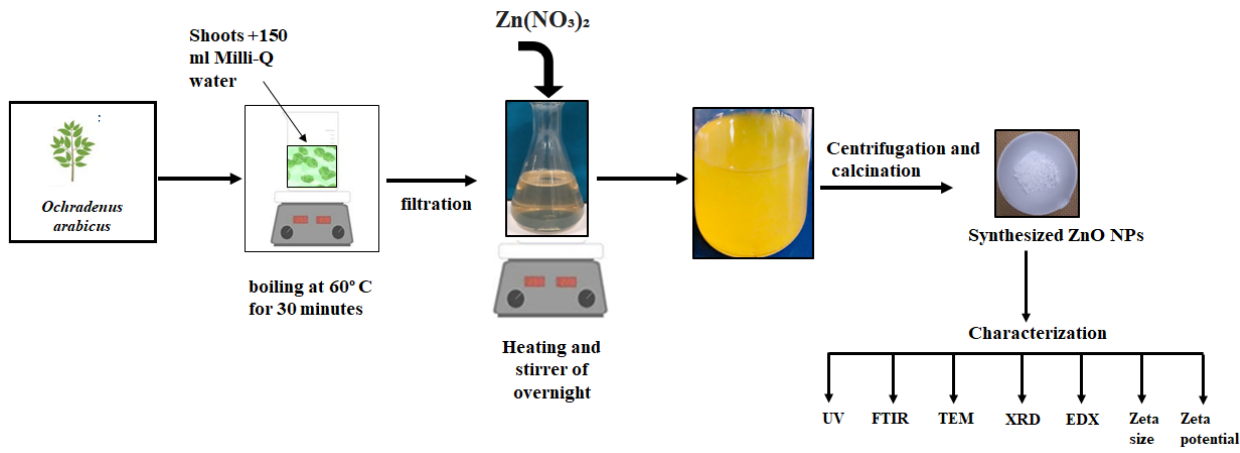
Figure 1. Steps of biogenic synthesis of ZnO NPs from the Ochradenus arabicus extract.